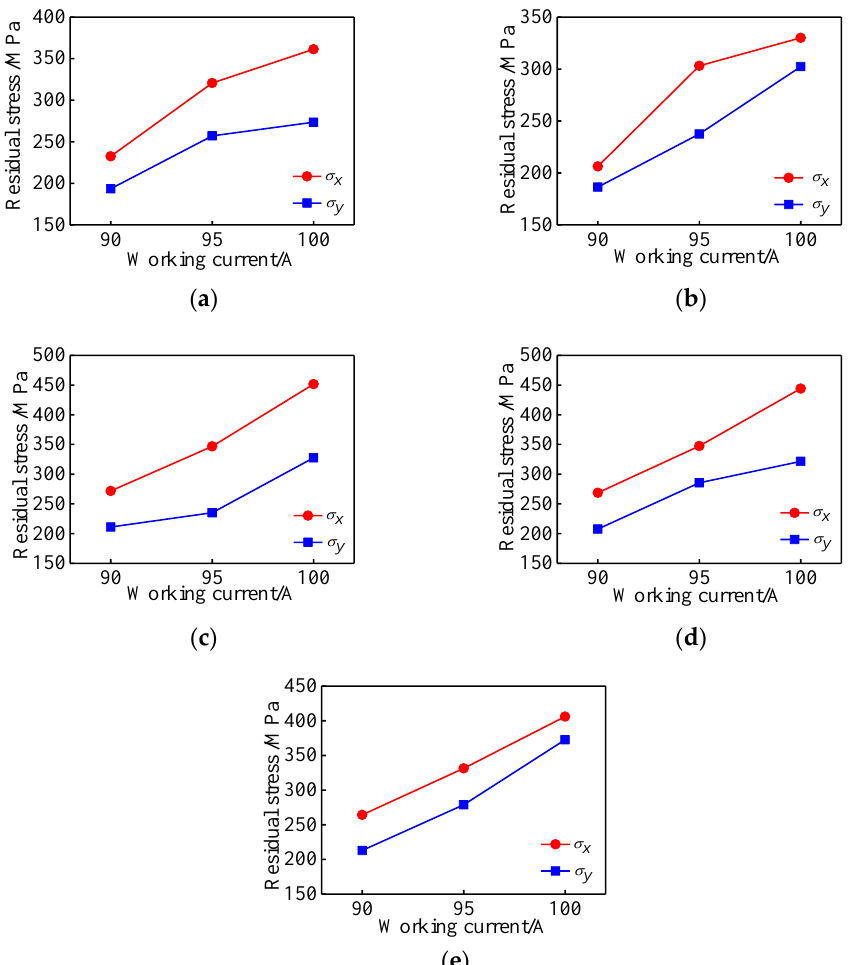
Figure 12. Residual stress at different working currents: ( a ) Test point A; ( b ) Test point B; ( c ) Test point C; ( d ) Test point D; ( e ) Test point E. point C; ( d ) Test point D; ( e ) Test point E.